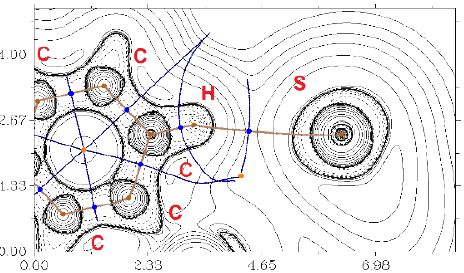
Figure 9. Contour line diagram of the Laplacian of electron density distribution ∇ 2 ρ ( r ), bond paths and selected zero-flux surfaces referring to hydrogen bond C7–H8 ··· S58 in model heterooctameric cluster {PhI(4-C 6 H 4 OMe)} 4 · {SCN} 4 . The remaining figure legend is in Figure 6.